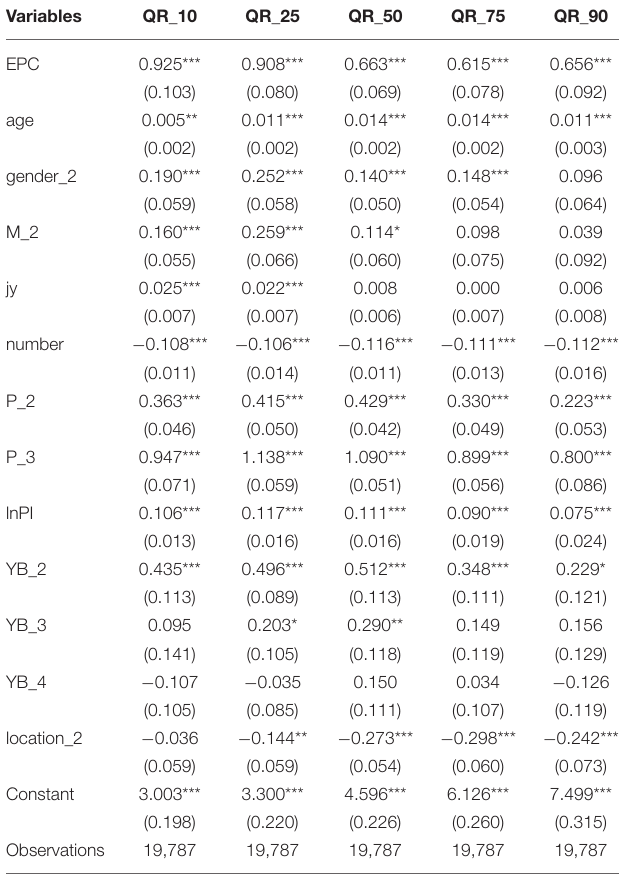
TABLE 7 | Robustness test